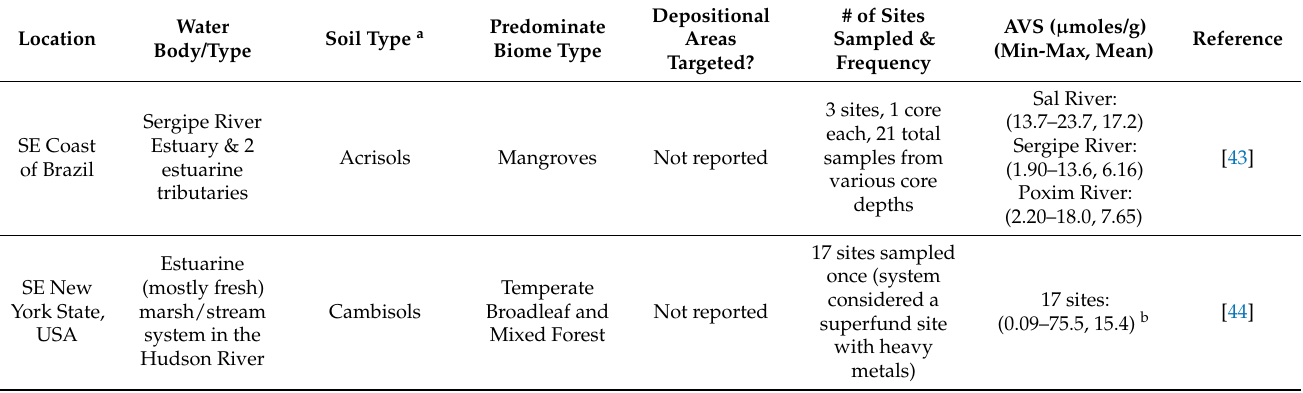
Summary of historical acid-volatile sulfides (AVS) sediment data estuarine and marine